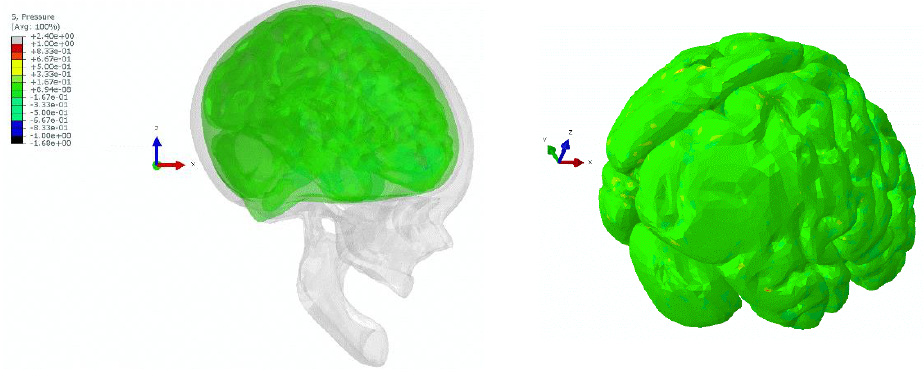
Figure 12. Contour plot of hydrostatic pressure (MPa) for the brain for the head – airbag impact at 389 ms.